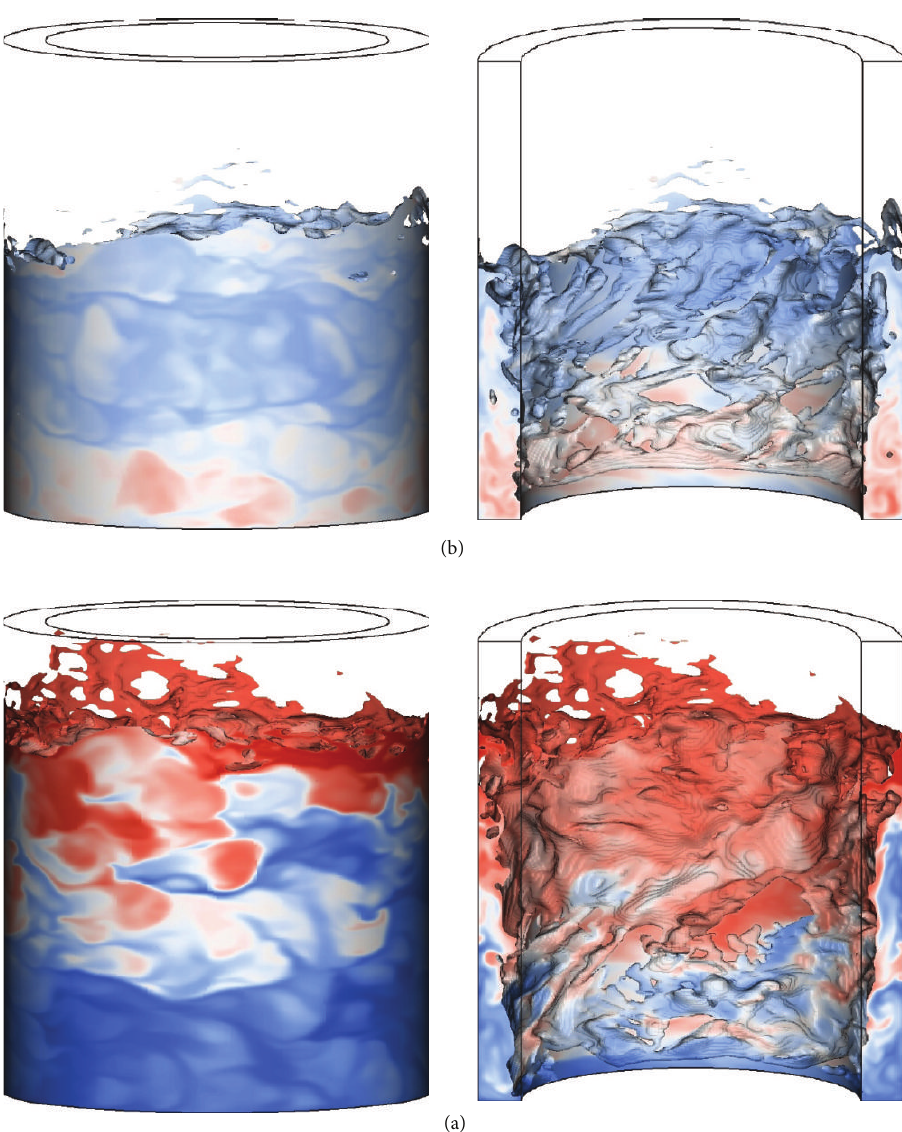
Figure 11: Snapshots of the liquid phase fractions in the 3D annular mixer model at (a) an early time ( ∼ 0.25 s) and ∼ 3s after startup (b) 3600 RPM with the left images showing a side view and the right a